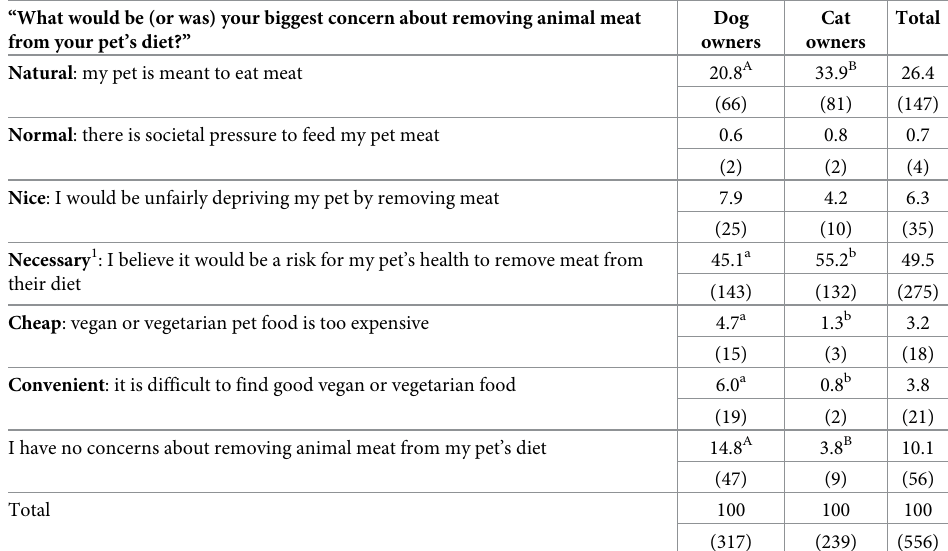
Survey respondents are grouped according to pet ownership. Concerns about removing meat from a pet’s diet are shown as percentage and number in parentheses. Superscript letters indicate significant differences within rows (between pet owner groups) as determined by the two-sided test of equality for proportions where ab indicates p < 0.05 and AB indicates p <